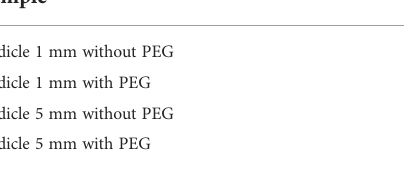
TABLE 1 Abbreviations of samples used in this